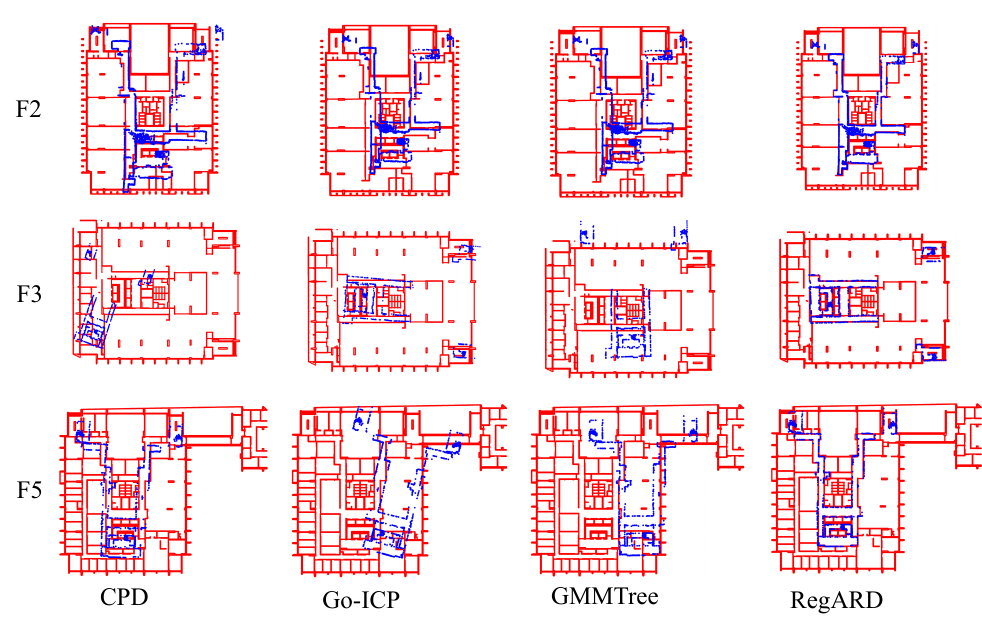
Figure 9. Comparison of the registration results by different